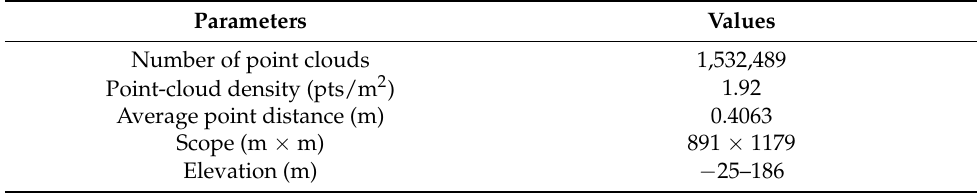
Table 3. Parameters related to the point-cloud dataset.